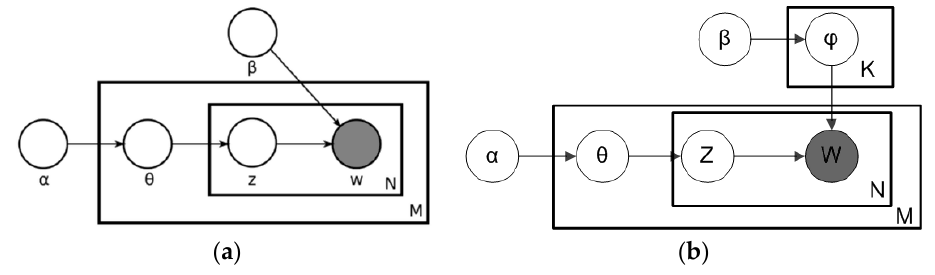
Figure 2. The latent Dirichlet allocation (LDA) process: ( a ) LDA plate notation; ( b ) LDA Dirichlet- distributed topic-word distributions. Source: adapted from Saura and Bennett